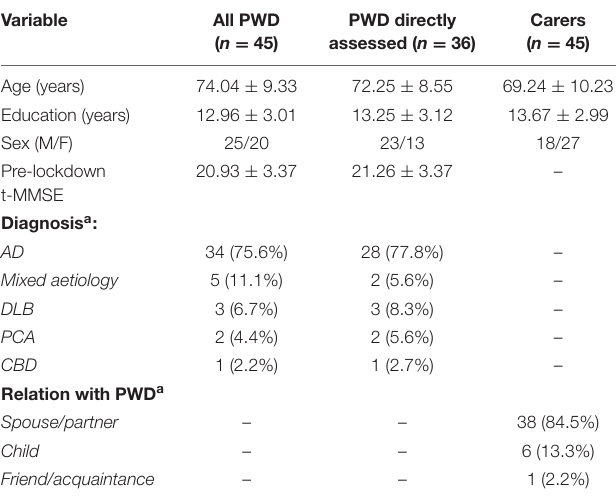
TABLE 1 | Demographic characteristics of people with dementia and carers (mean ± SD